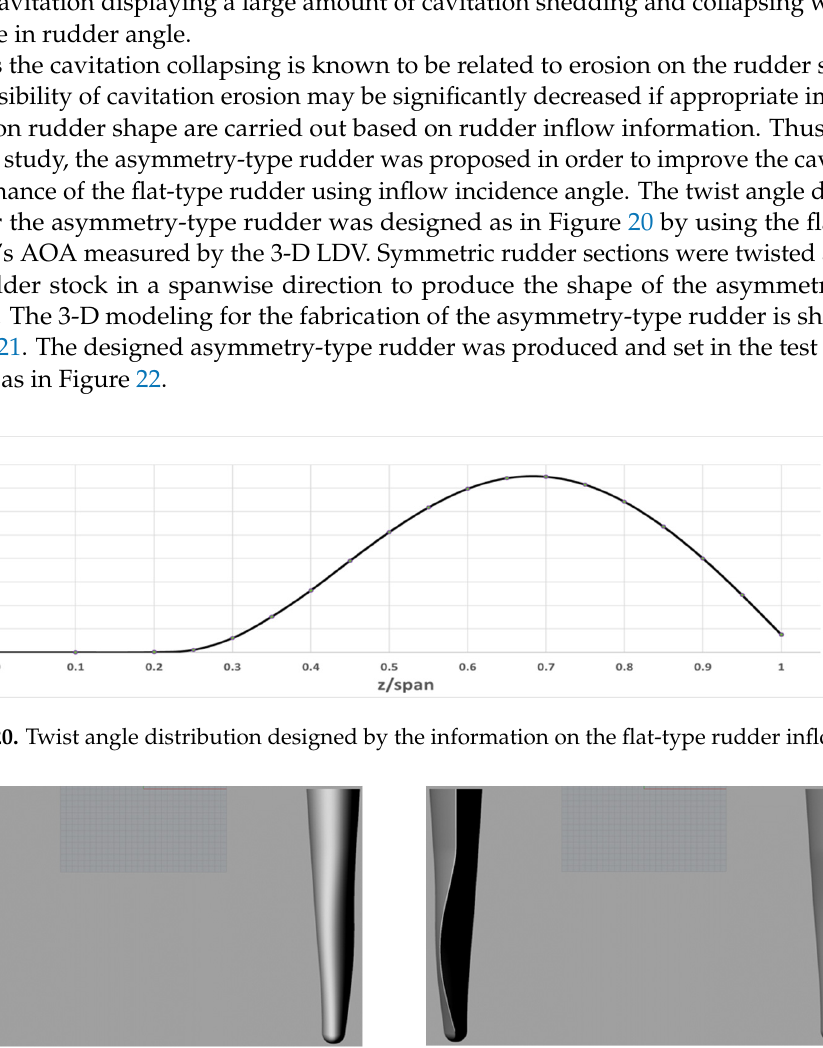
Figure 19. Cavitation observation of flat-type rudder with the variation of its deflection angle in the large cavitation tunnel (experiment). ( a ) 0°, ( b ) − 2°, ( c ) − 4°, and ( d ) − 8°.